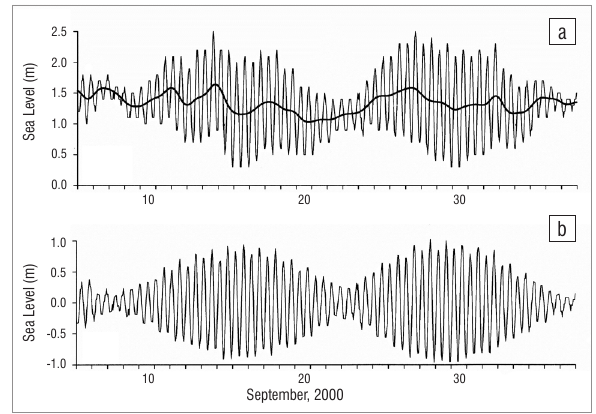
Figure 3: Sea level measured at Port Elizabeth in 2000. The upper figure (a) shows the original hourly data (light line) with the superimposed long-period variability (dark line). The bottom figure (b) shows the tidal oscillations with the long-period variability removed.